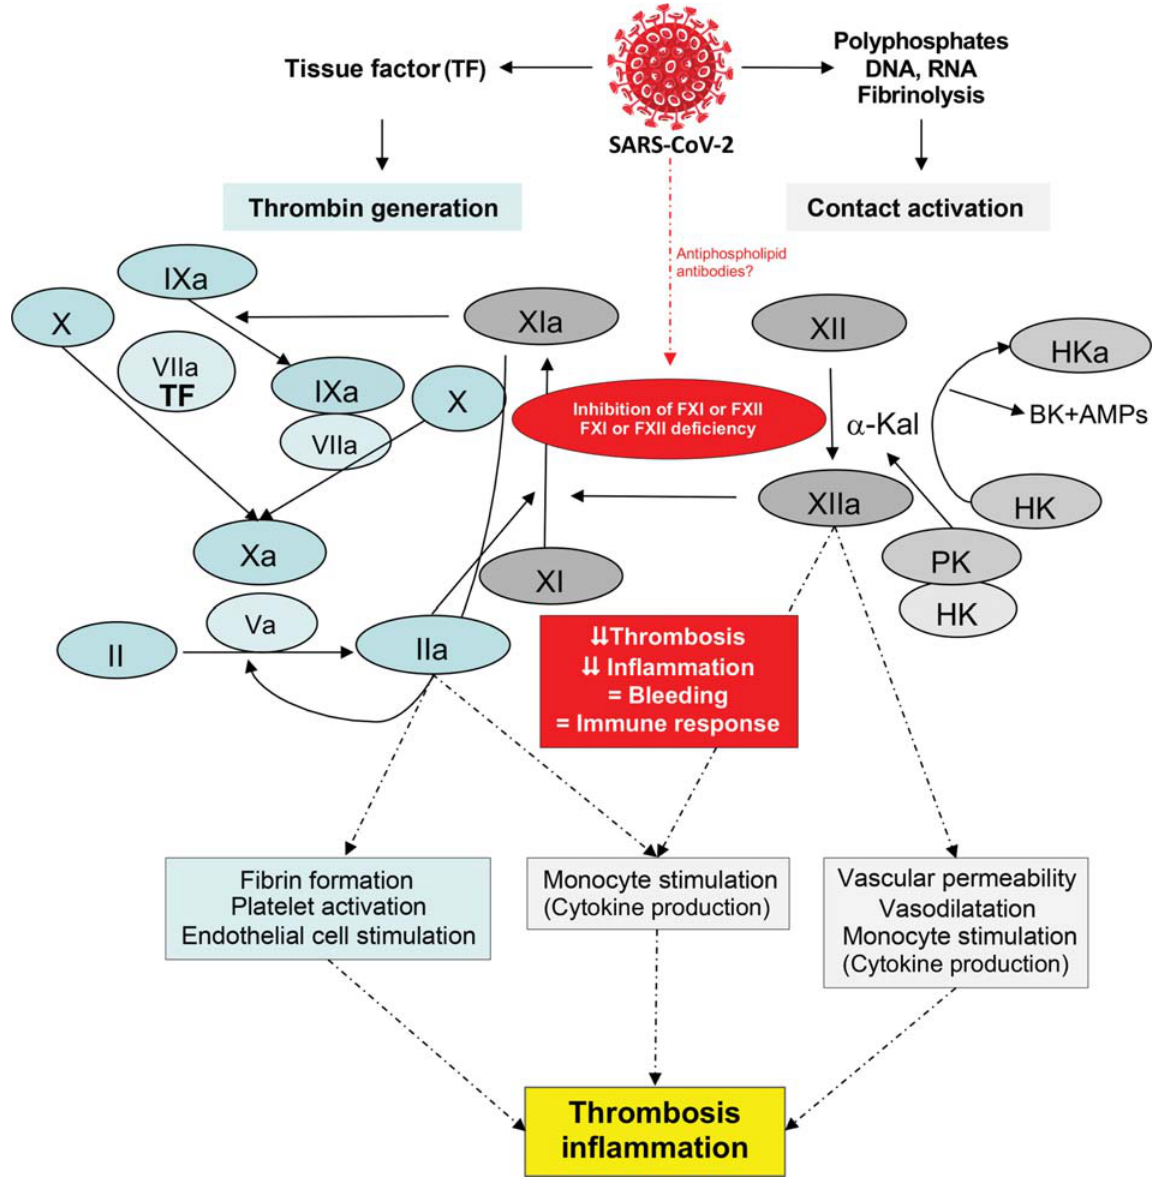
Fig. 1 Schematic representation of the potential role of FXI and FXII in the thrombotic and in fl ammation complications induced by SARsS-CoV-2 infection. The antithrombotic and anti-in fl ammatory capacity of the inhibition of contact pathway and FXI and FXII de fi ciency could be a therapeutic option in this disease with low risk of bleeding. Whether SARS-CoV-2 infection could produce antiphospholipid antibodies able to cause an acquired FXI de fi ciency with protective role remains to be clari fi ed. F, factor; SARS-CoV-2, severe acute respiratory syndrome-